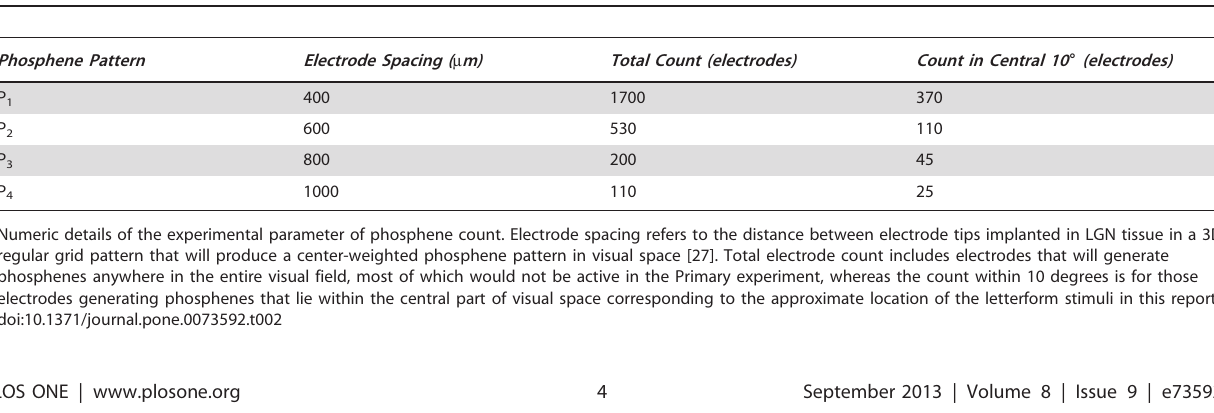
Table 2. Phosphene